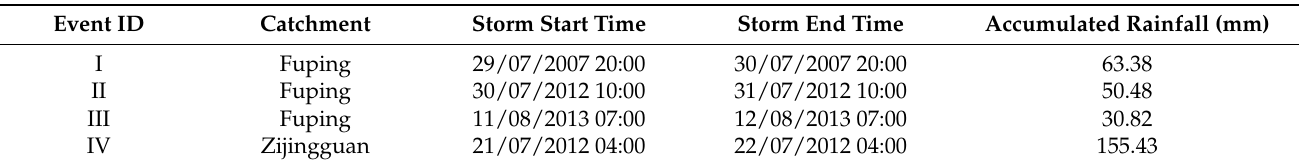
Table 2. Duration, accumulated rainfall, and maximum stream flow of the four selected 24 h storm events.